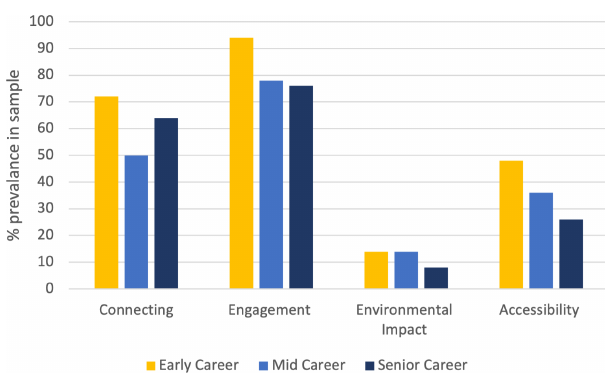
Figure 1. The prevalence of the theme categories within each sam- pled, self-identified career stage population, by